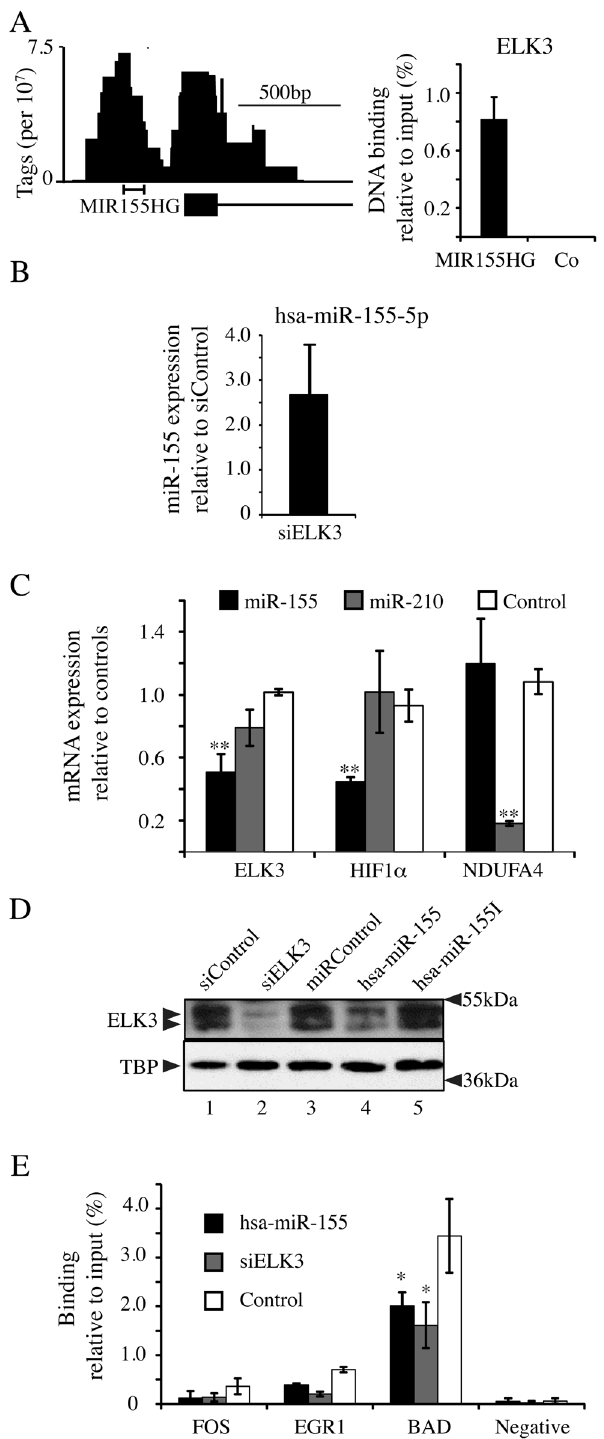
Figure 2. ELK3 feedback loop with hsa-miR-155-5p. (A) ELK3 DNA binding to the BIC (MIR155HG) gene promoter as shown in the ChIP-seq normalised bedgraph and by ChIP-QPCR in comparison to the negative locus at Chr12: 96463102–96463229 (Three separate experi- ments, error bars represent the S.D. between experiments). (B) miR-155 expression in cells treated with siRNA against ELK3 (Four transfection experiments, error bars represent the S.D.). (C) HUVEC cells treated with miR-155, miR-210 or control miR were analysed for mRNA expression of ELK3, HIF1 a and NDUFA4 by RT-QCPR (Three separate